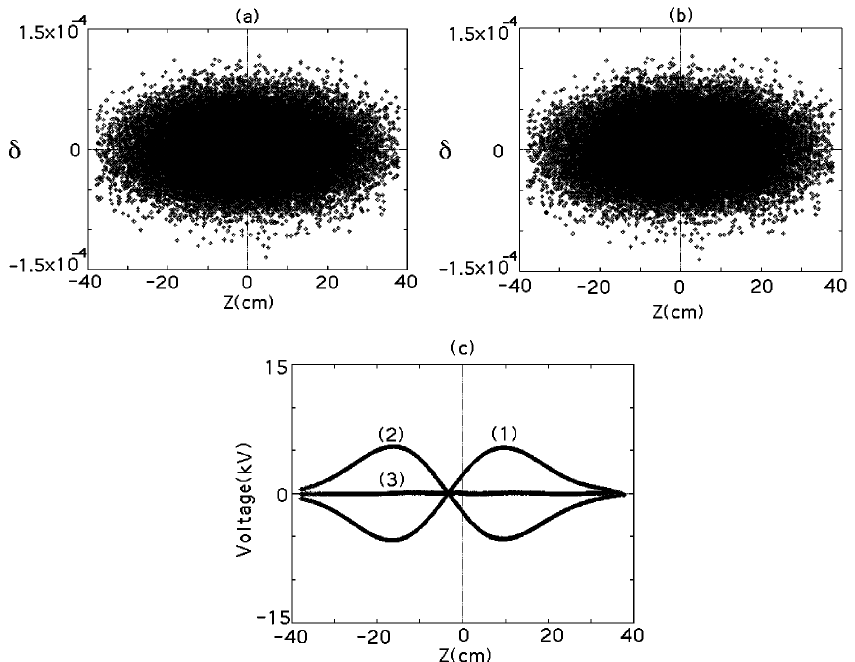
FIG. 3. The longitudinal beam phase space after 1 turn (a) and 1000 turns (b) when two rf voltages are applied. (c) shows voltages due to the two rf cavities [curve (1)], the bunch wake [curve (2)], and the net voltage [curve (3)] after 1000 turns. The bunch wake is well compensated by the two rf cavities, with (cid:86) (cid:114)(cid:102)(cid:49) (cid:173) (cid:52)(cid:46)(cid:50)(cid:54) kV, (cid:86) (cid:114)(cid:102)(cid:50) (cid:173) (cid:49)(cid:50)(cid:46)(cid:49)(cid:50) kV, f (cid:49) (cid:173) (cid:51)(cid:46)(cid:55)(cid:53)(cid:53) rad, f (cid:50) (cid:173) (cid:51)(cid:46)(cid:52)(cid:49)(cid:53) rad, j (cid:173) (cid:48)(cid:46)(cid:49) V . (cid:102) (cid:114)(cid:102)(cid:49) (cid:173) (cid:56)(cid:50)(cid:51) MHz, and (cid:102) (cid:114)(cid:102)(cid:50) (cid:173) (cid:51)(cid:57)(cid:57) MHz. s d (cid:173) (cid:51) 3 (cid:49)(cid:48) 2 (cid:53) , h (cid:49) (cid:173) 2 (cid:49) 3 (cid:49)(cid:48) 2 (cid:54) , and j (cid:90) k (cid:110) (cid:104) 051001-4